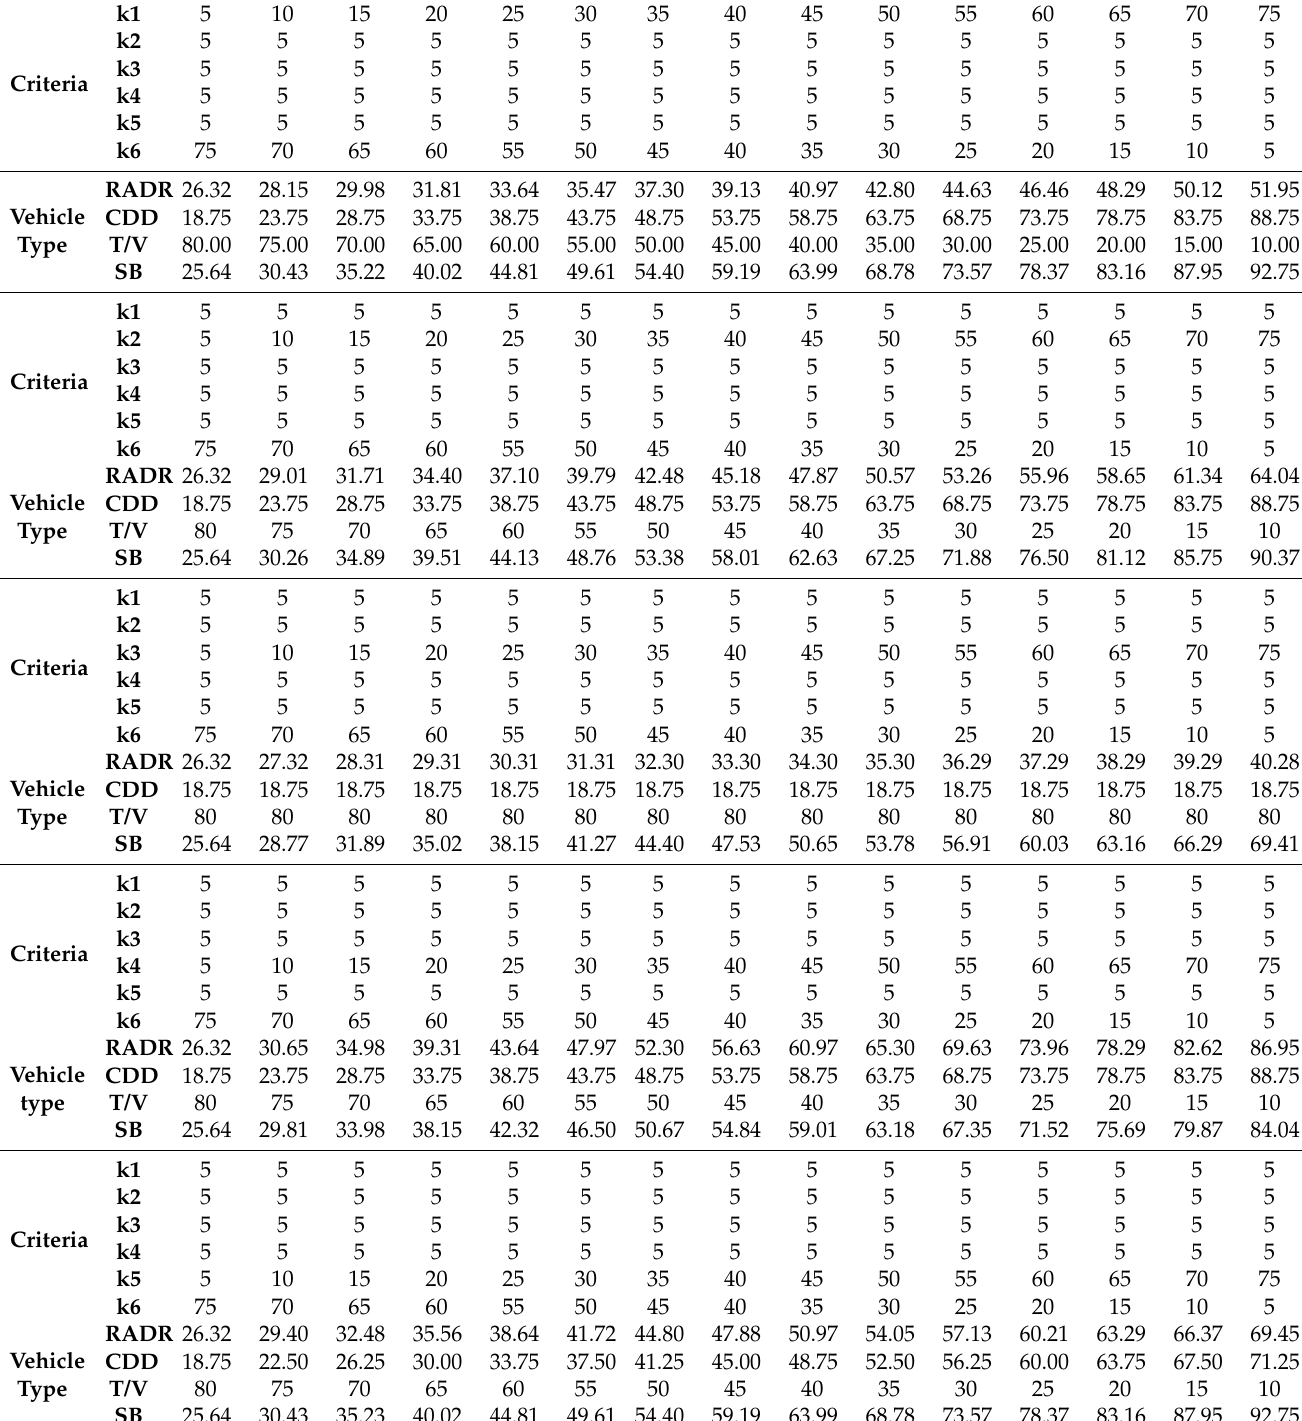
Table 15. Sensitivity analysis in the case of S1 (where CDD—civil delivery drones, T/V—conventional delivery trucks/vans, SB—smart